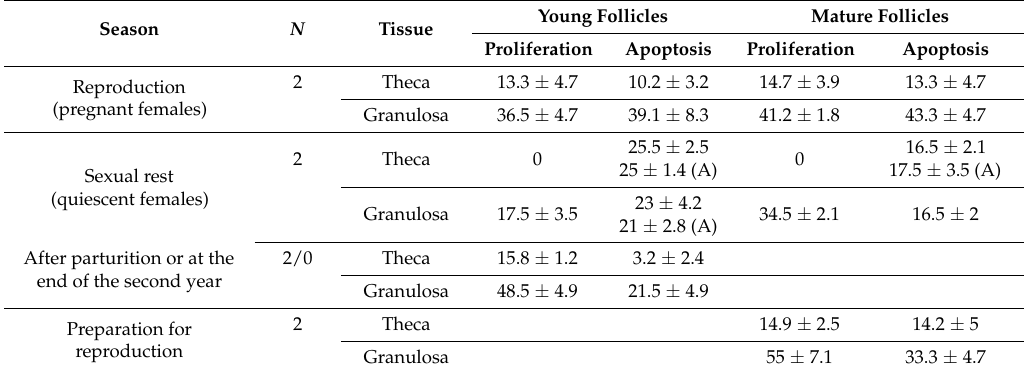
Table 3. Proliferation indexes (Ki67) and percentages of apoptotic cells (TUNEL/Apostain) in Typhlonectes compressicauda during the year for young and mature follicles. (A): apoptosis detected with Apostain method. N : number of females.